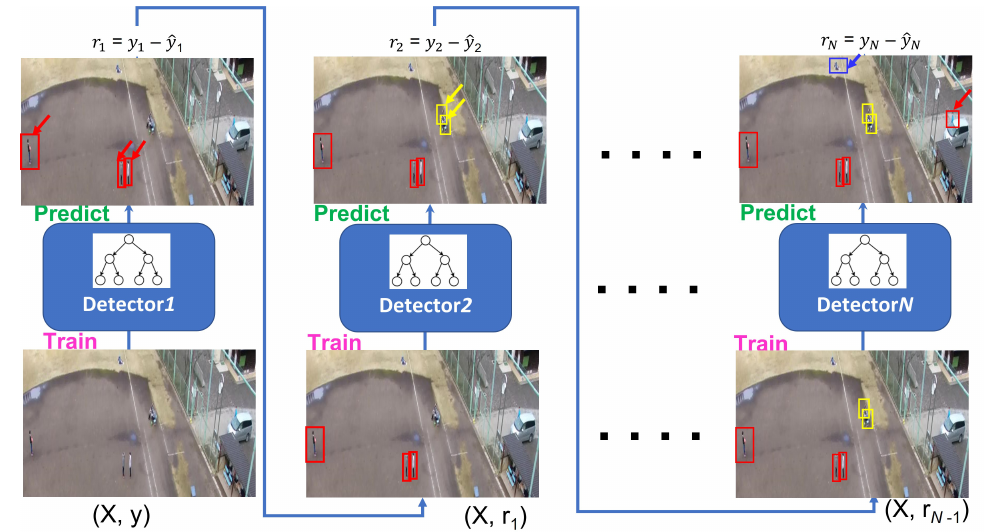
Figure 3. This diagram explains the gradient boosting classifier for learning and retraining on difficult instances. The boosting technique involves weight adjustment based on the previous decision tree prediction. The output features of YoloDector are encoded as feature vectors for input into the boosting classifier. The regularization is introduced for this model using shallow boosting